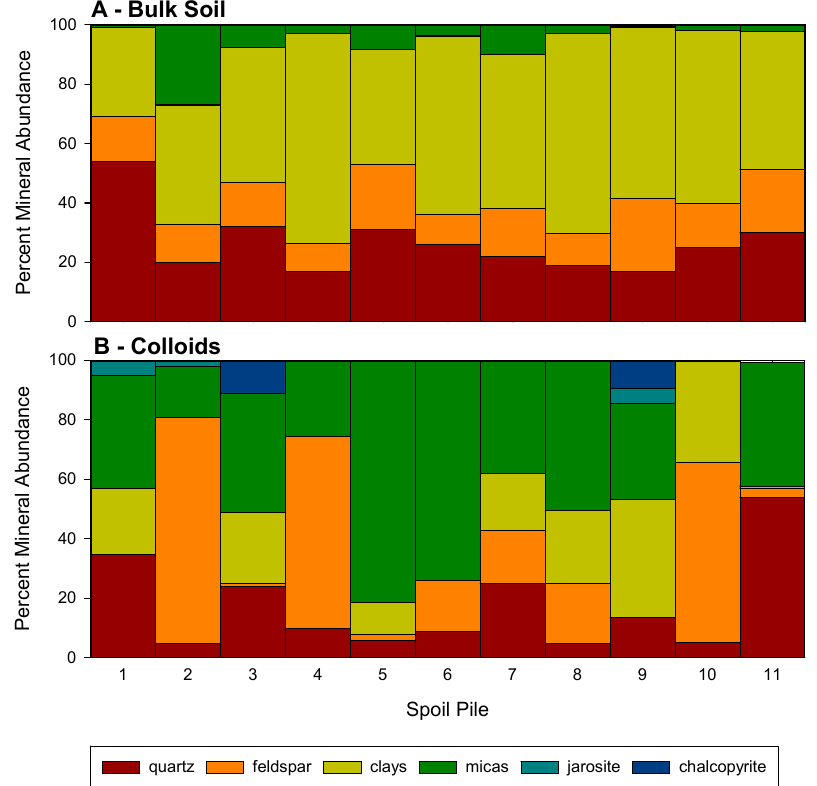
Figure 2. Mineralogical composition of ( A ) the bulk soil developing on abandoned mine spoil and ( B ) colloids extracted from bulk soil samples. Mineral group members are as follows: feldspar = orthoclase + albite; clays = kaolinite + chlorite + vermiculite; and micas = muscovite + biotite. Details on the XRD pattern fit results are presented in the SI document. Bulk soil XRD data are from Smart (2021) [27].